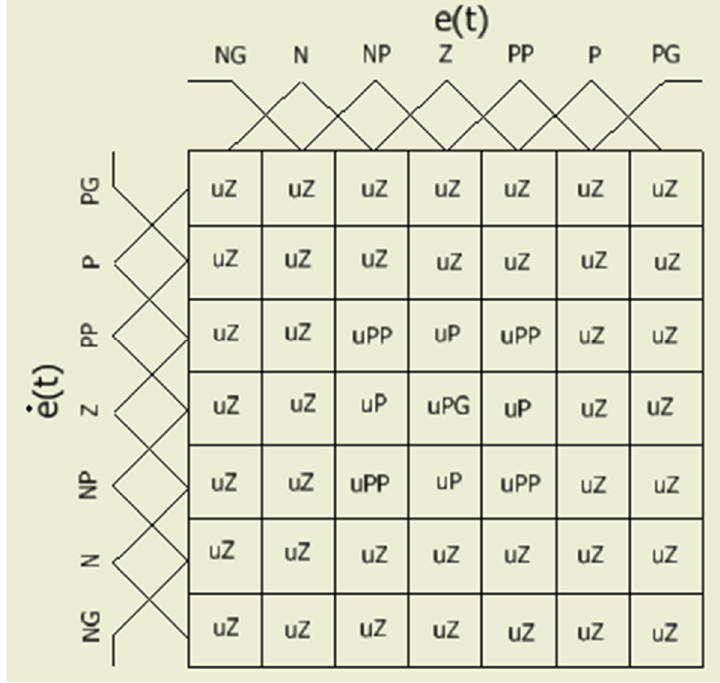
Figure 17. Matrix of rules for the integrative action.